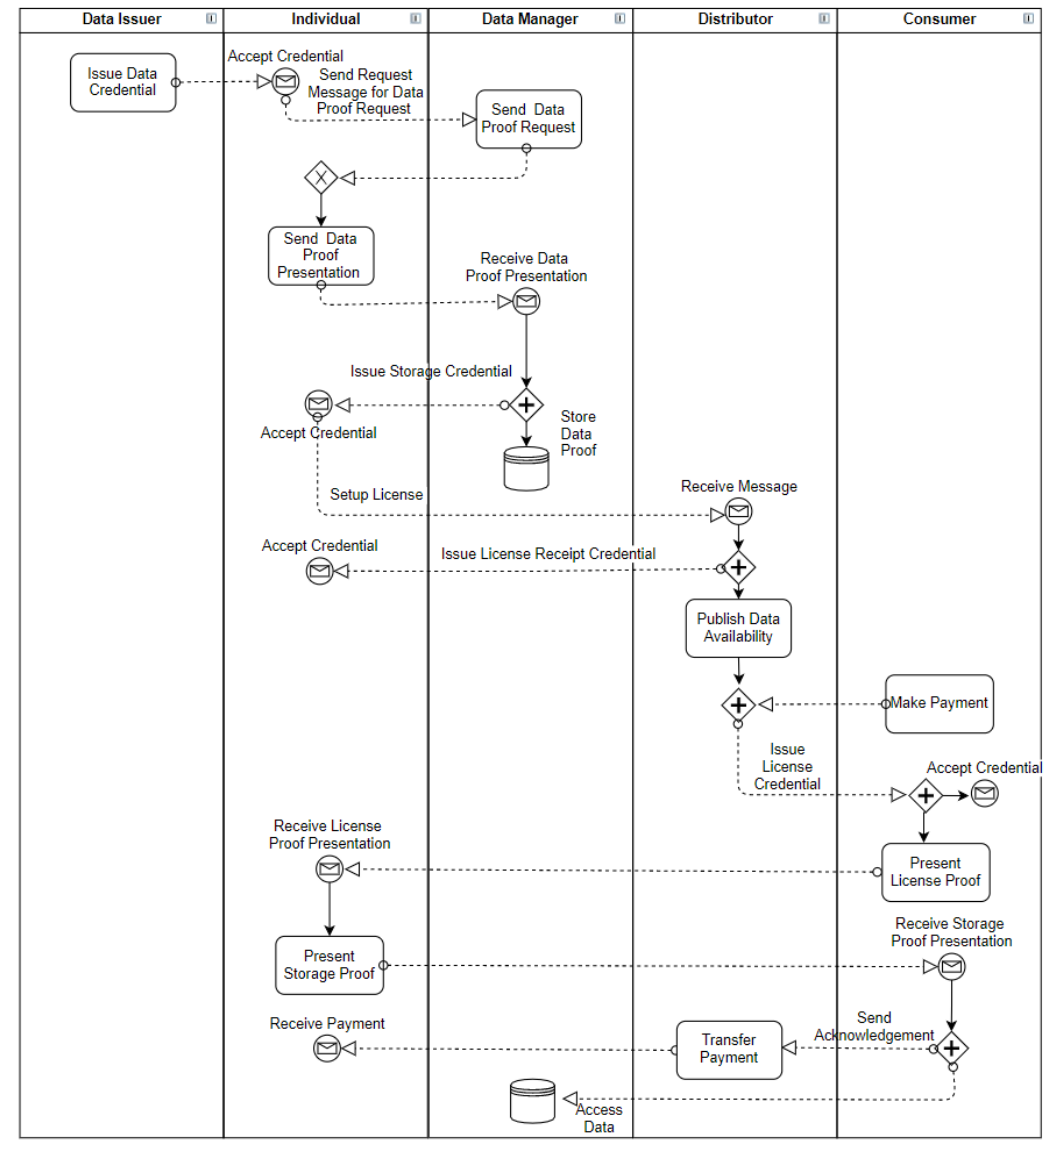
Fig. 6. Overview of roles and process